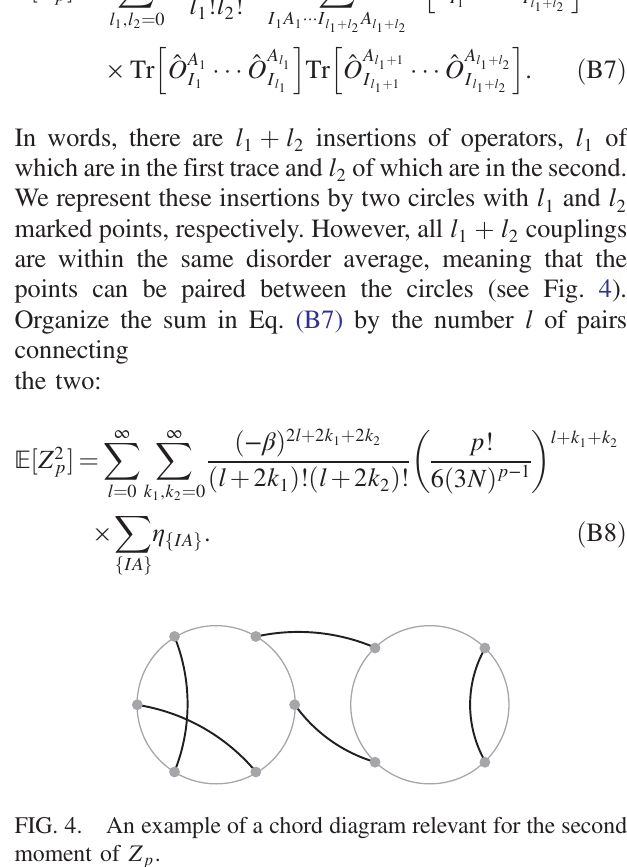
FIG. 4. An example of a chord diagram relevant for the second moment of Z p